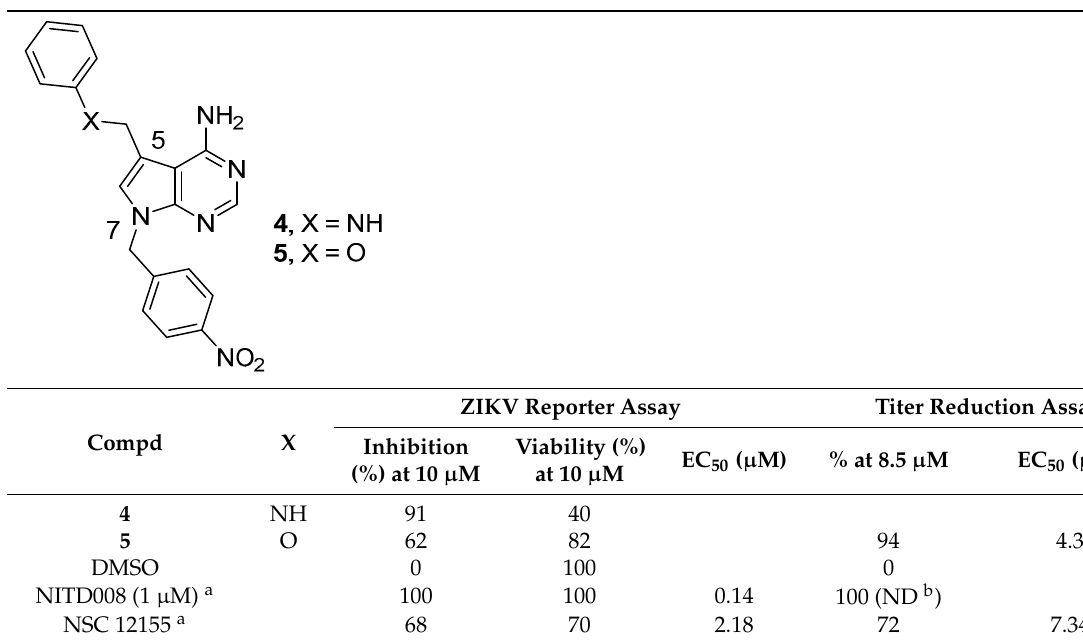
Table 1. SAR study on the scaffold replacement.